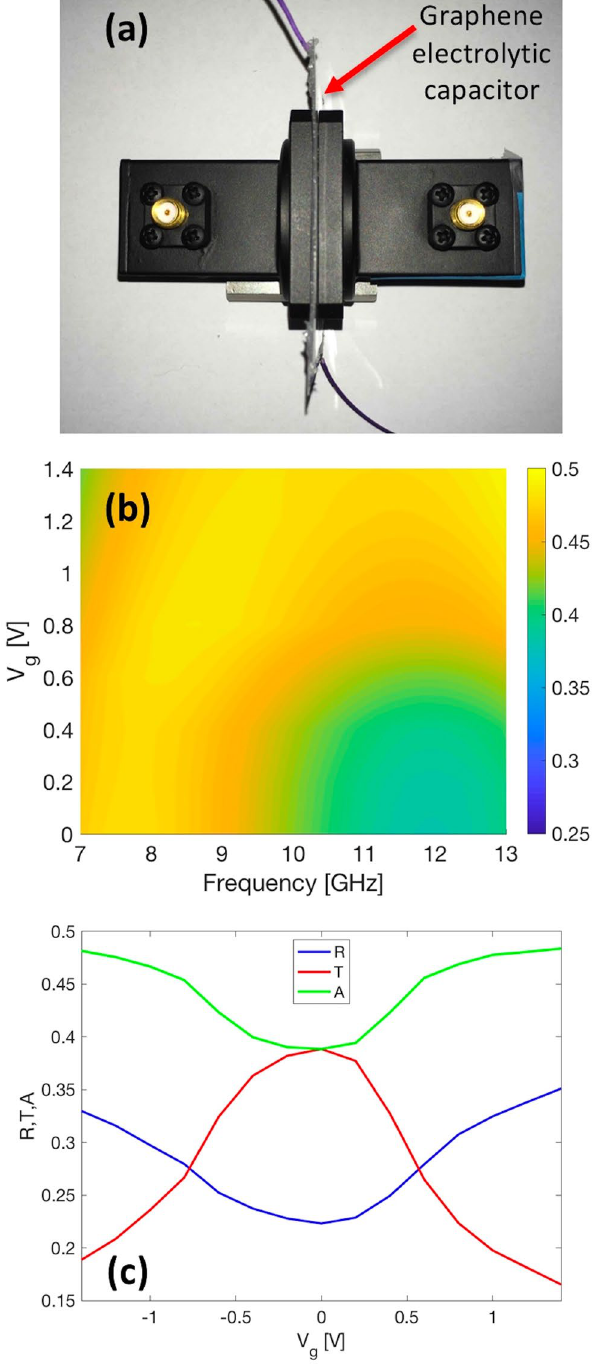
Figure 4. ( a ) Picture of the experiential setup with the two WR-90 transitions that sandwich the graphene electrolytic capacitor. ( b ) Absorption map. ( c ) Experimental reflectance, transmittance and absorbance when the gate voltage is varied in the DES electrochemical window at 13